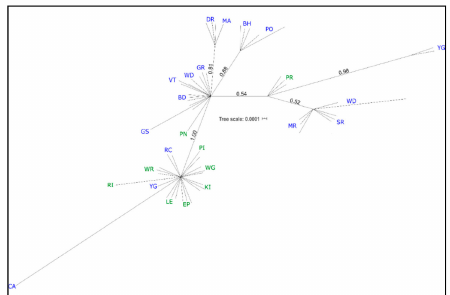
Figure 2. cpDNA Bayesian phylogeny. Unrooted tree with posterior probabilities shown for each clade. Individuals are labeled with their population (as in Table 1); those given in blue are native and those in green are